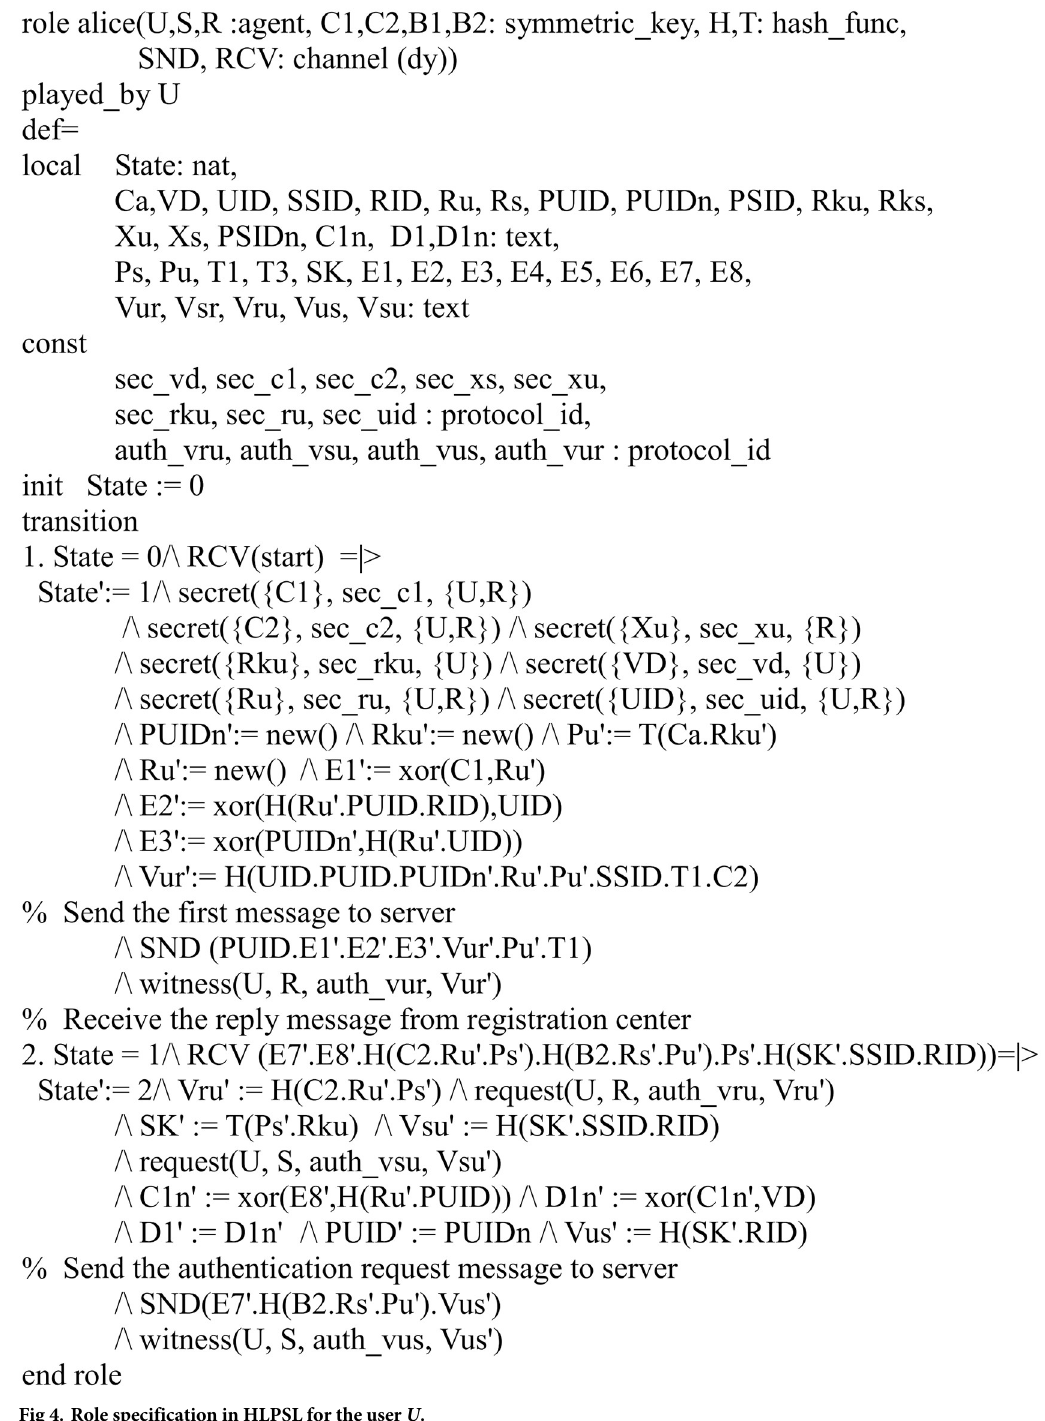
Fig 4. Role specification in HLPSL for the user U